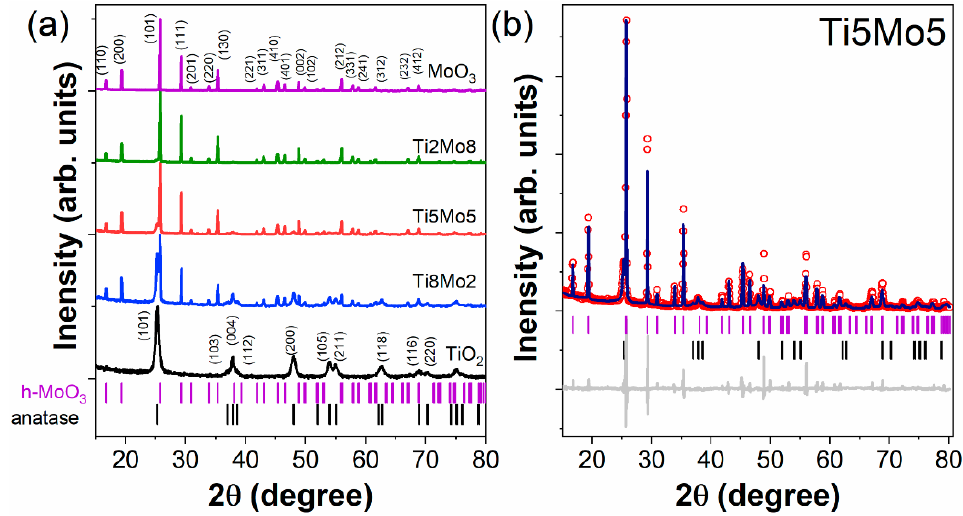
Figure 10. XRD patterns for TiO 2 -MoO 3 composites. ( a ): Miller indices are shown on the pronounced peaks and ( b ): Rietveld refinement for selected Ti 5 Mo 5 sample [99].